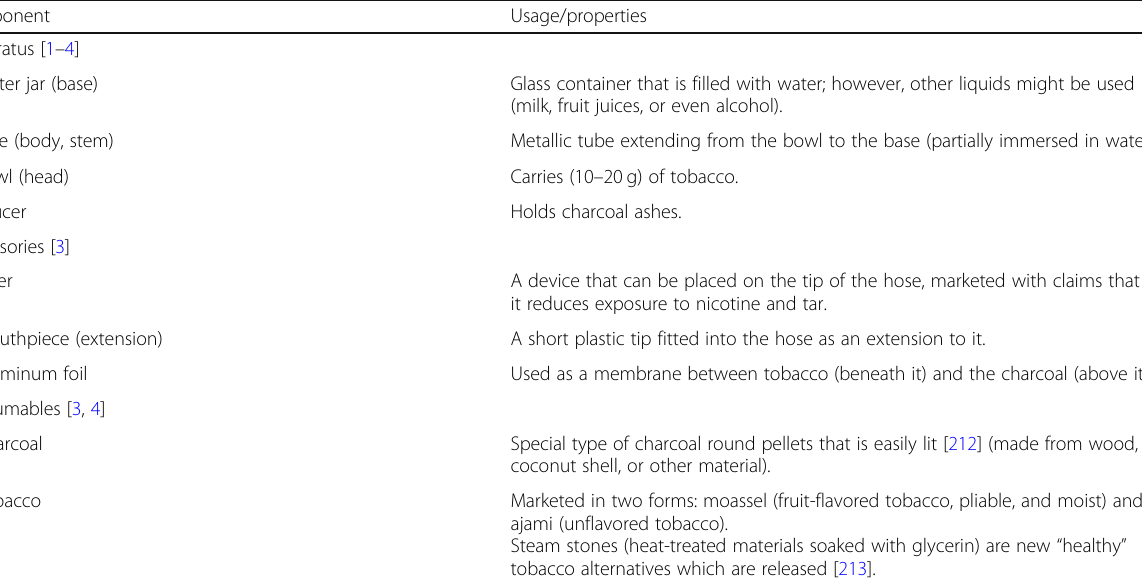
Table 1 Hookah apparatus components and their use